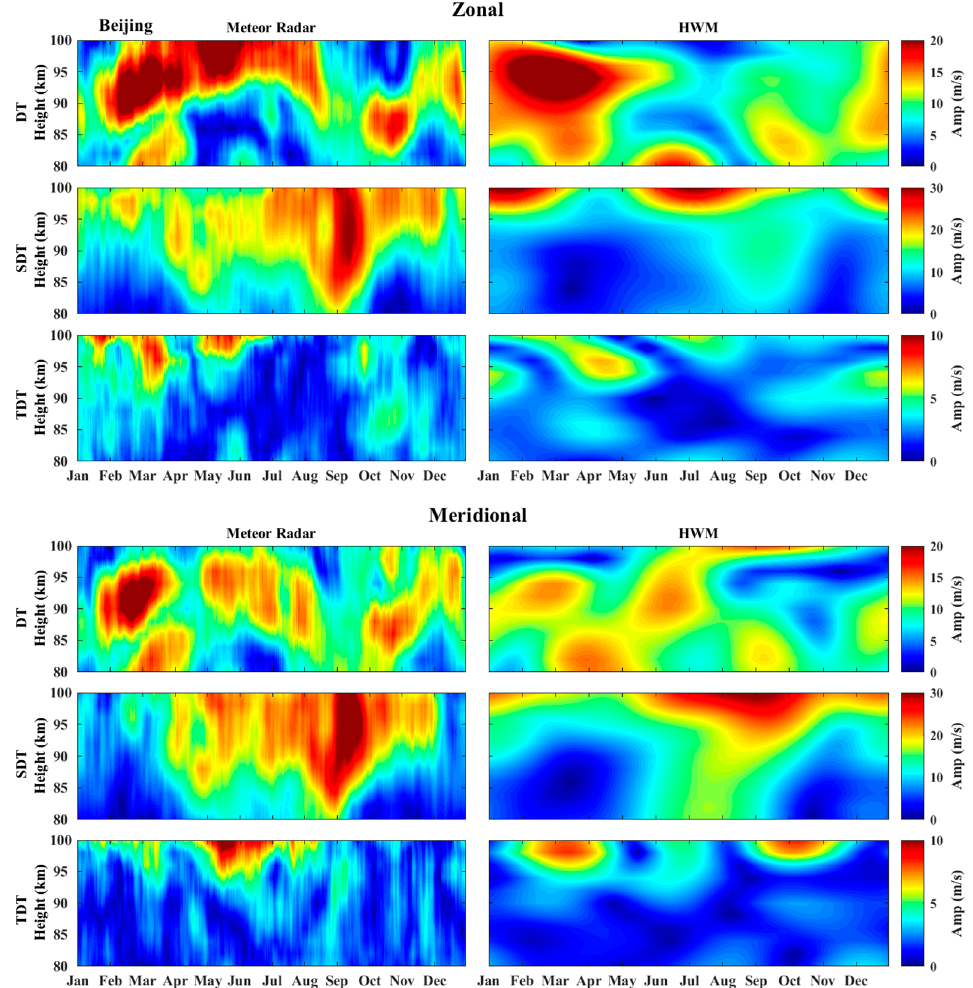
Figure 5. Diurnal (DT), semidiurnal (SDT), and terdiurnal (TDT) tidal amplitude obtained from Beijing meteor radar measurements ( left column ) and HWM14 ( right column ).